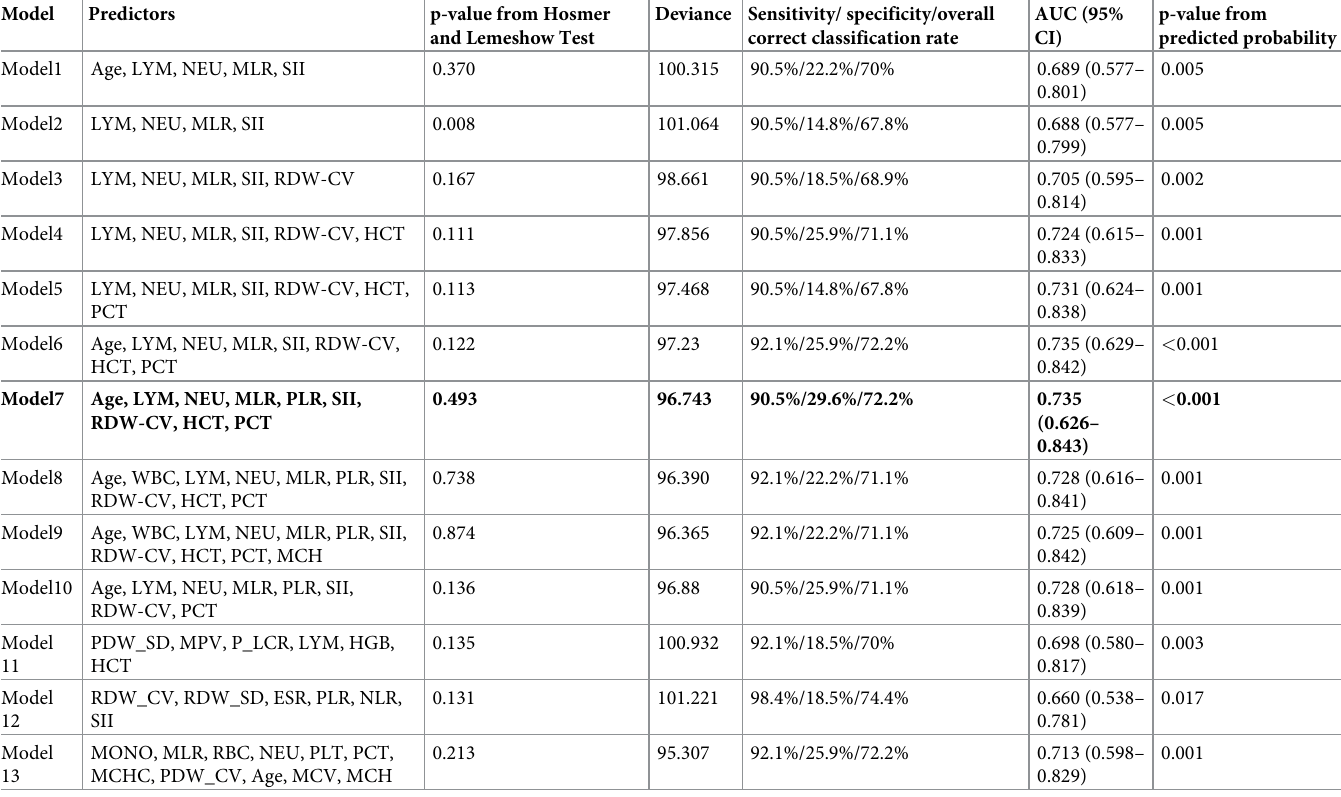
Table 2. Logistic regression analysis of the models of